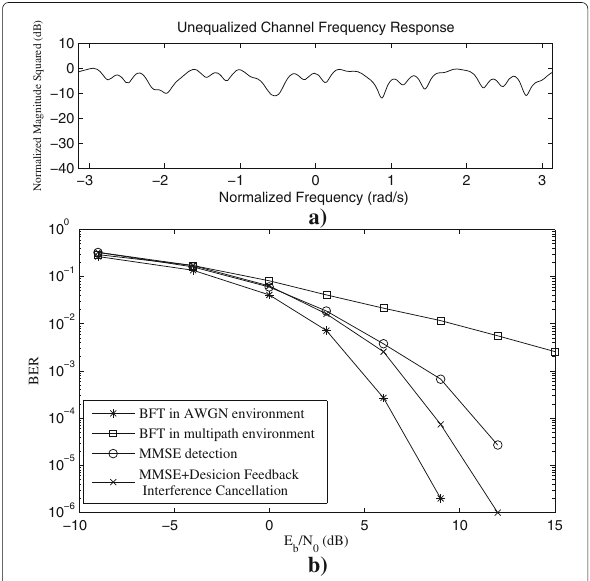
implementation, a choice based on computational com- plexity must be made. For a deep-fading frequency selec- tive channel as shown in Fig. 9a, the BER performances are compared in Fig. 9b. The performance without inter- ference suppressing is unacceptable. The MMSE-DD-PIC algorithm does a good job, and its performance is much better than that of simple MMSE training.